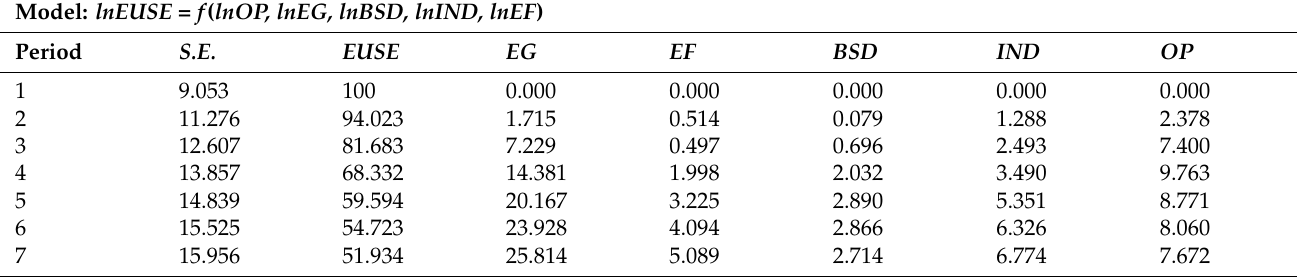
Table 6. Outcome of variance decomposition factor